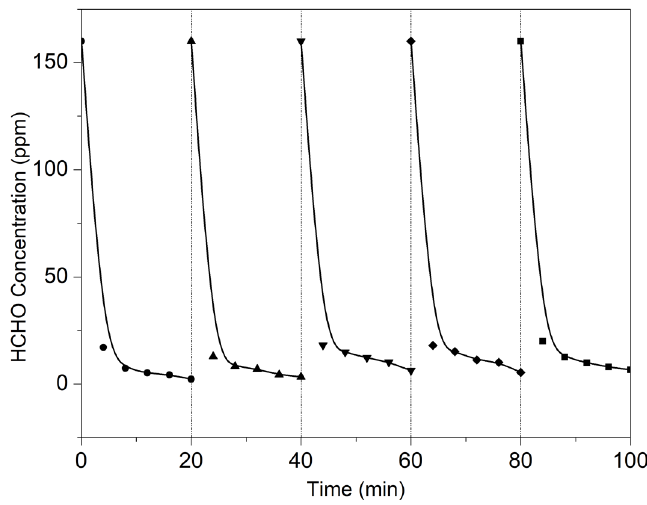
Figure 10. Cyclic performance test for HCHO removal.